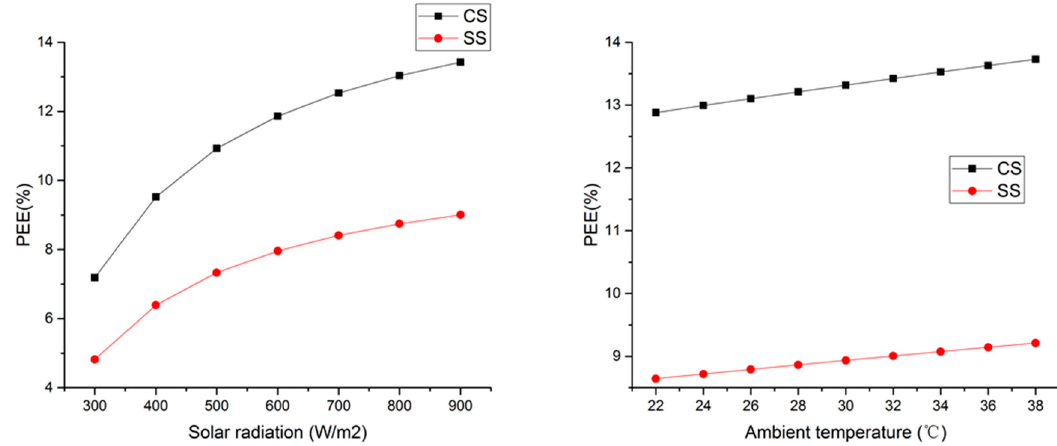
Figure 6. PEE of the systems as a function of solar radiation and ambient temperature.